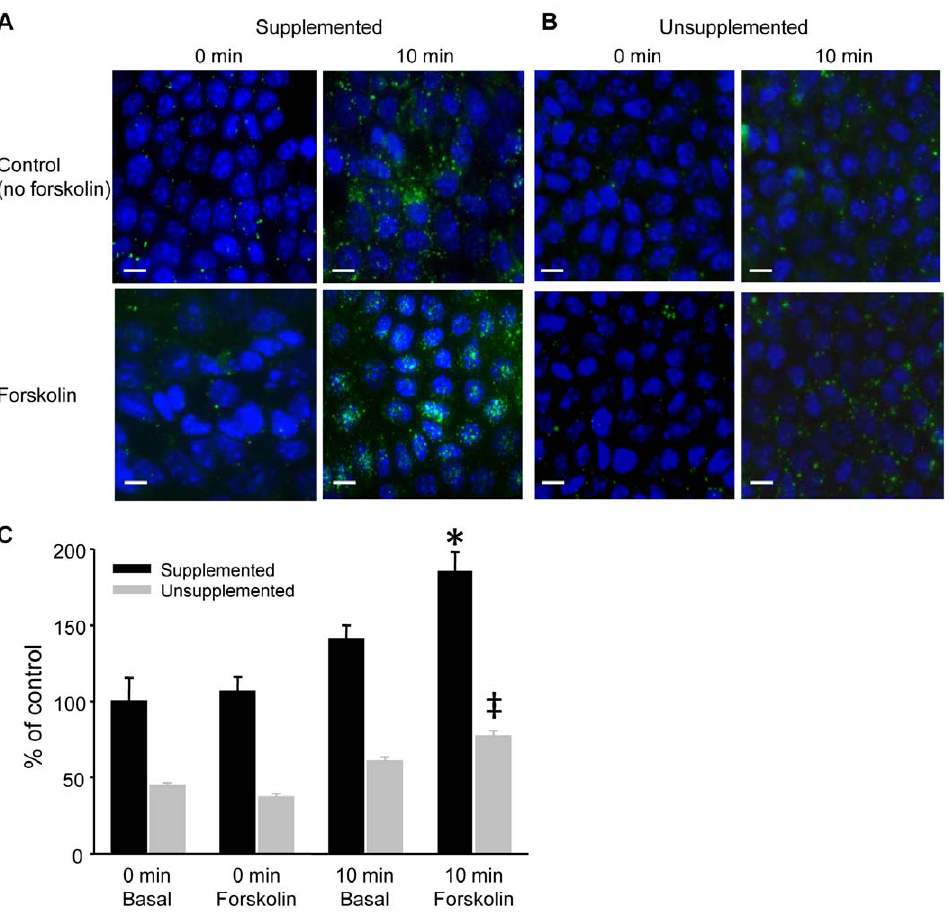
Figure 6. Confocal fluorescent images of FM1-43X endocytosis in mpkCCD cells. (A) Representative maximum projection images from confocal stacks obtained at 0 min and 10 min in basal (no forskolin) and forskolin stimulated (10 m M) cells previously cultured in fully supplemented media. (B) Representative images as in (A) from cells cultured without dexamethasone supplementation. (Bars represent 10 m m). (C) The number of vesicles internalized per cell is presented as a percentage of the fully supplemented counts at time 0 min (N=3, n . 200). Counts from cells cultured without dexamethasone supplementation (Unsupplemented) were significantly lower than cells in full supplementation for all conditions (p , 0.05). For fully supplemented cells, there was a significantly greater number of vesicles internalized in the presence of forskolin than from cells without forskolin stimulation after 10 minutes (*, p , 0.05). The percent of internalized vesicles in unsupplemented cells stimulated with forskolin was smaller than the equivalent vesicle number at 10 min in cells with full supplementation ( { , p ,